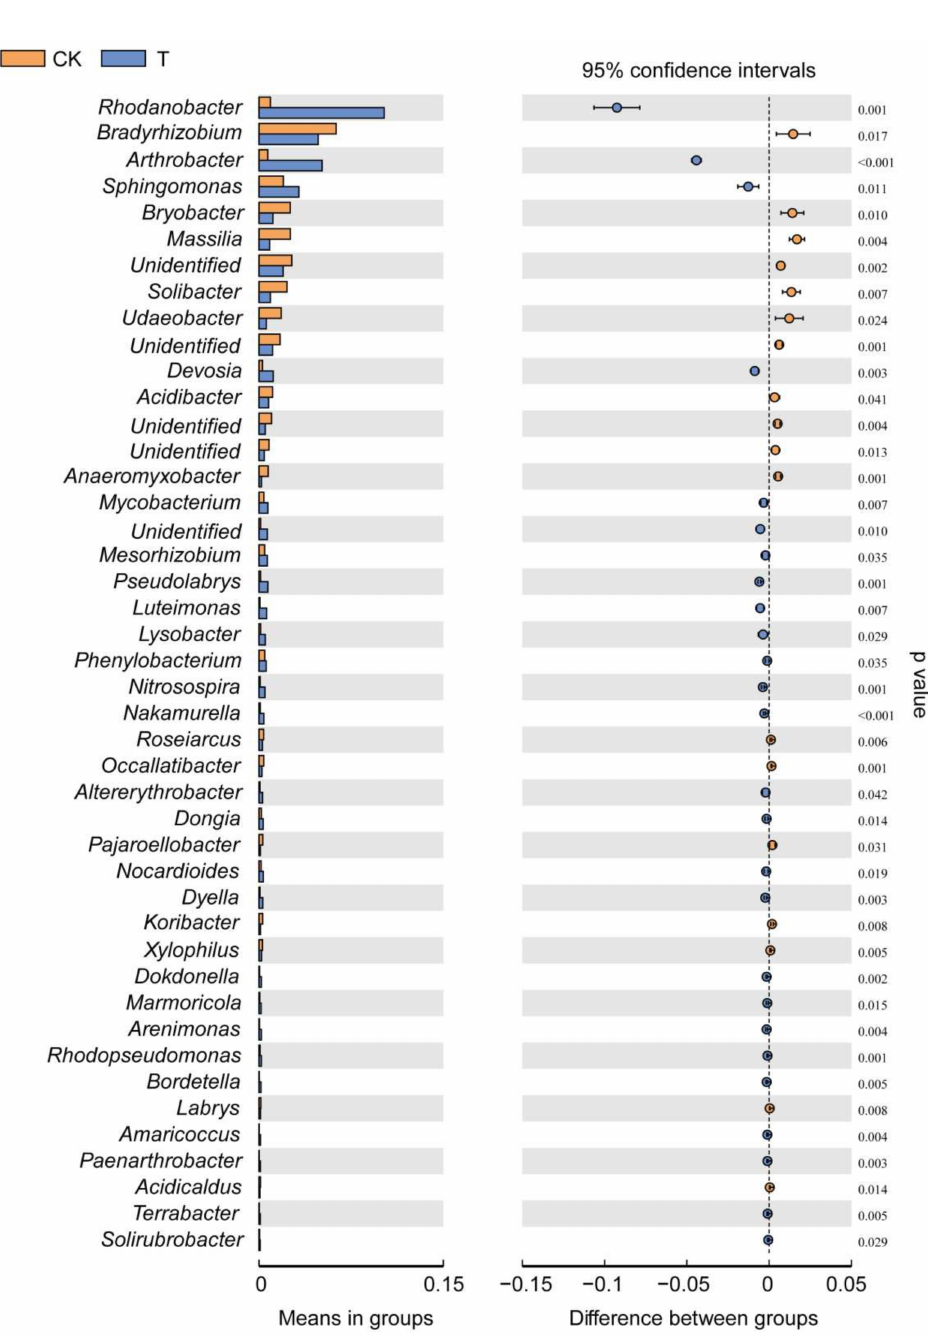
Figure 6. Extended error bar plot indicates the differences in bacterial genera relative abundance in the bioorganic fertilizer and no-fertilizer treatments. Only significantly different genera between the two groups were depicted (Welch’s t -test, p <